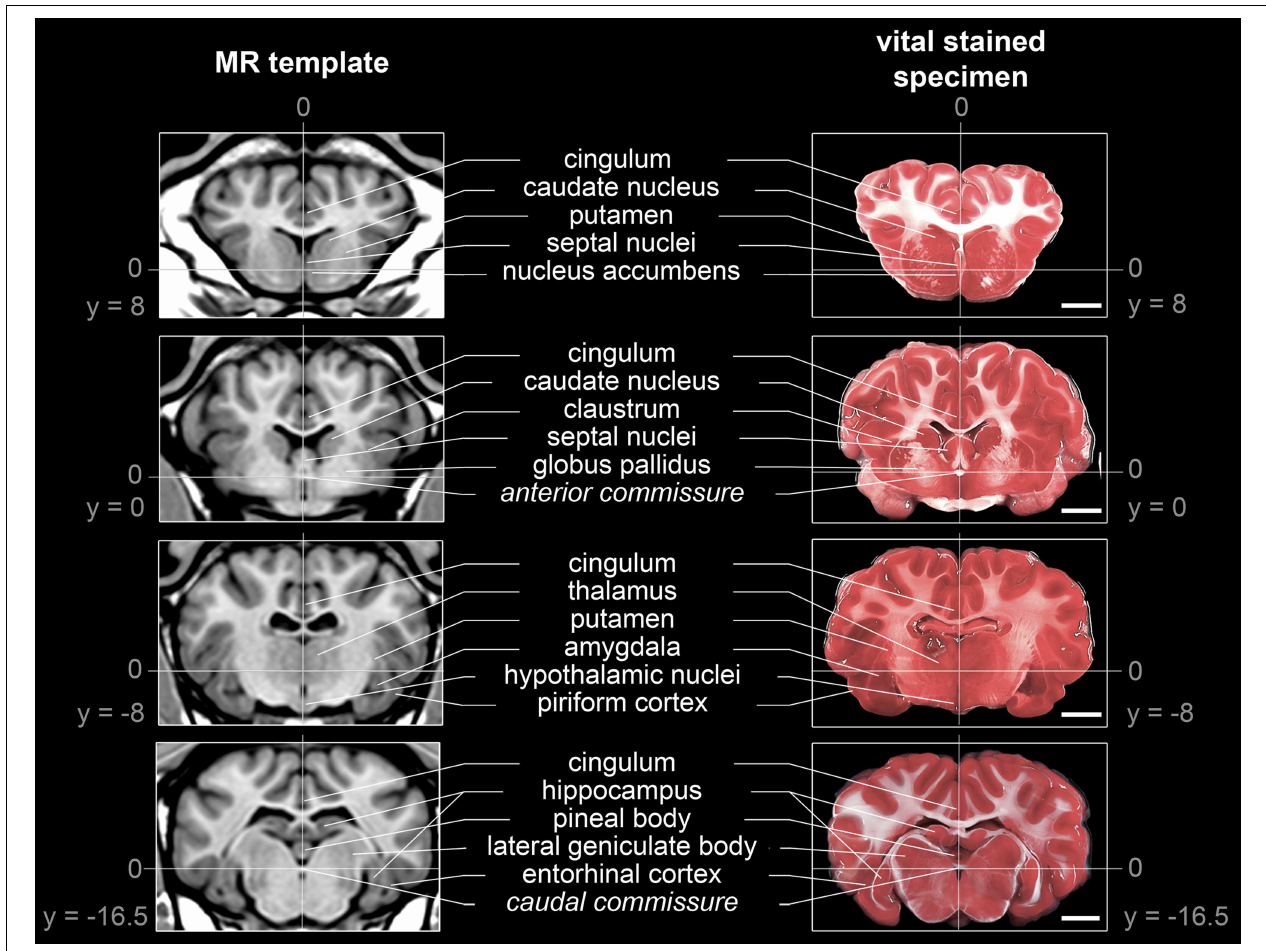
FIGURE 4 | Comparison of subcortical structure detectability in the population-averaged T1w template and a TTC-stained brain slice. Structures were selected according to neuro-anatomical reference paper (Cooley and Vanderwolf, 2004; Schmidt et al., 2012): The anterior commissure (AC) as origin of the stereotaxic space